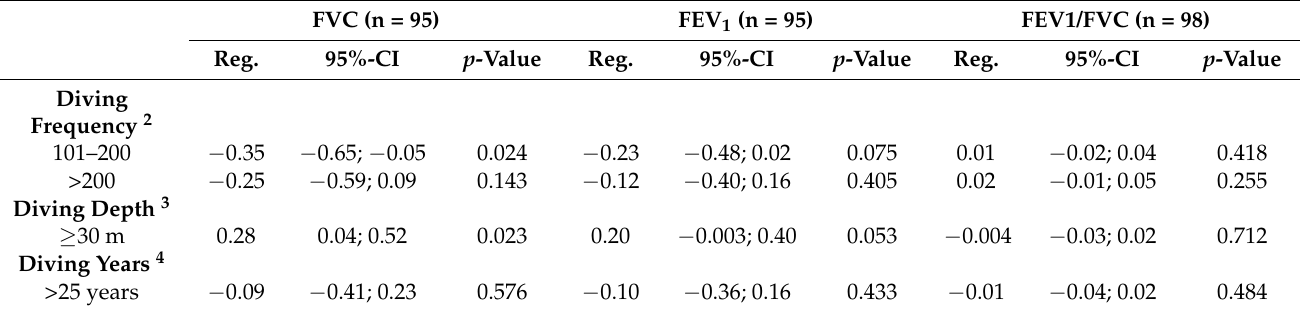
Table 4. Association of diving frequency, diving depth and diving years on lung function in divers only 1